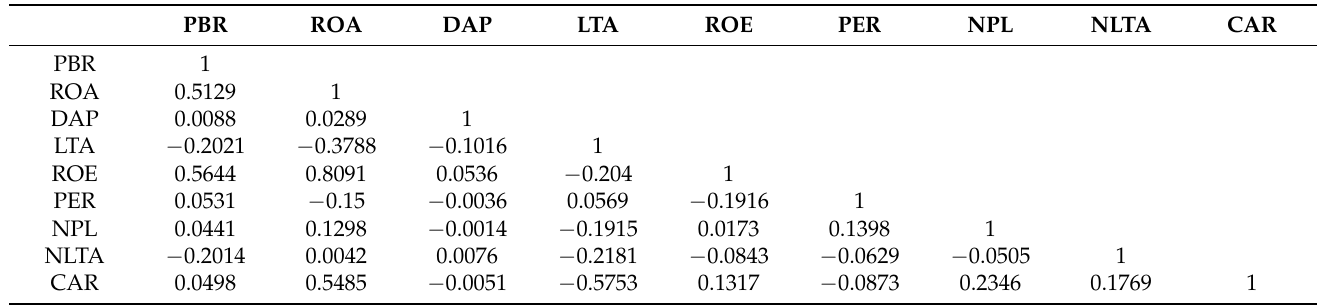
Table A1. Correlation matrix.